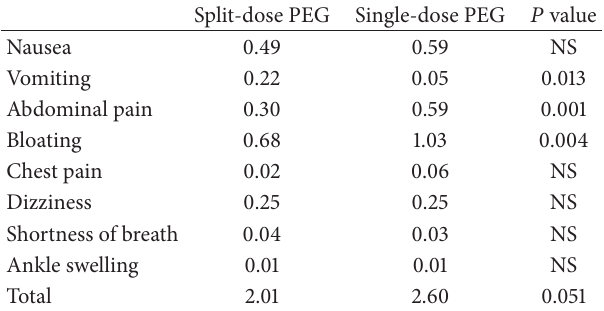
Table 4: Adverse events (group symptom score). Split-dose PEG Single-dose